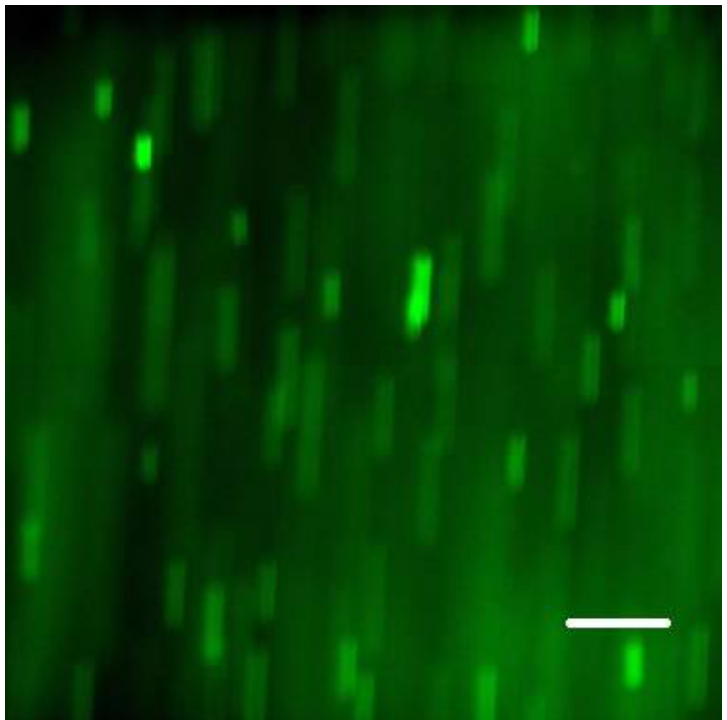
Figure 8. Linear pump (Fusion 100 Infusion Pump; Chemyx, Inc., Stafford, TX, USA) for accurate constant delivery of injected material (liquid disinfectant) with inserted disposable syringe connected to the flow cell on the stage of Zeiss Axiomat microscope through silicone tubing.